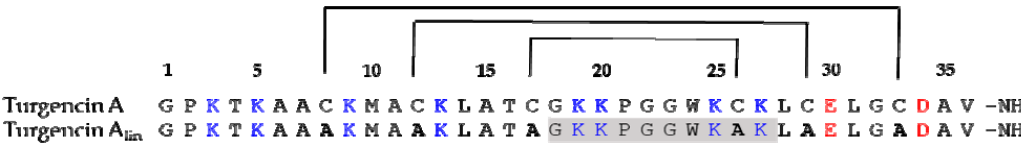
Figure 1. Amino acid sequences and disulfide bond connectivity of turgencin A and its linear derivative turgencin A lin where all Cys residues were replaced by Ala (shown in bold). The potential 10-residue lead peptide sequence containing the PGGW core is shaded in grey.